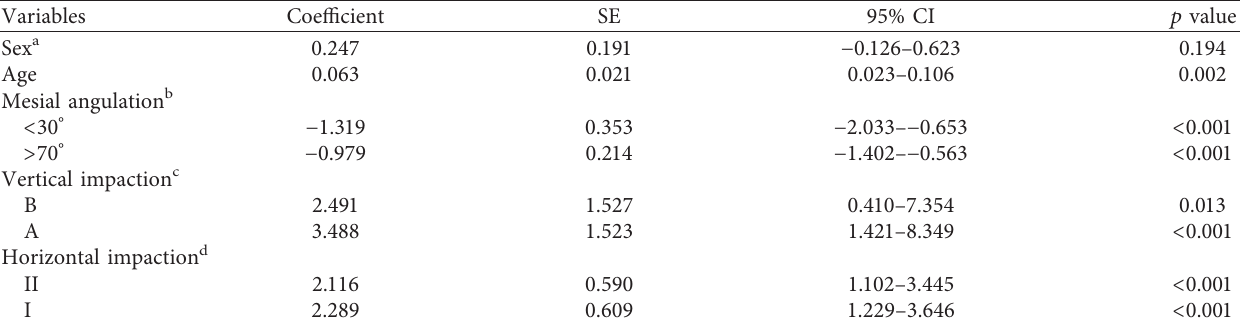
Table 2: Univariate logistic regressions of associations between distal caries in M2Ms and demographic/radiographic characteristics ( N � 446).